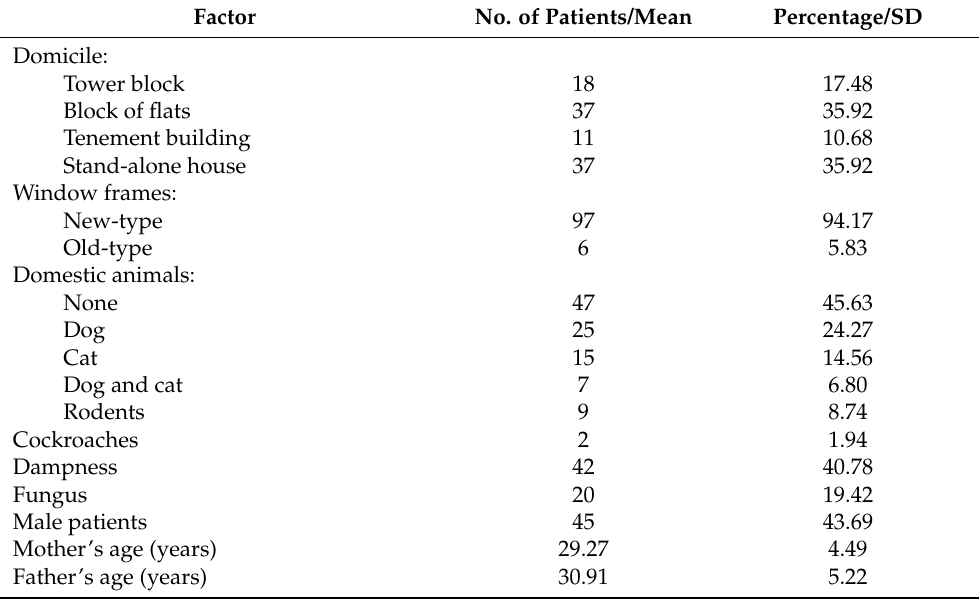
Table 1. Baseline characteristics of the study cohort (environmental and family factors) ( n =